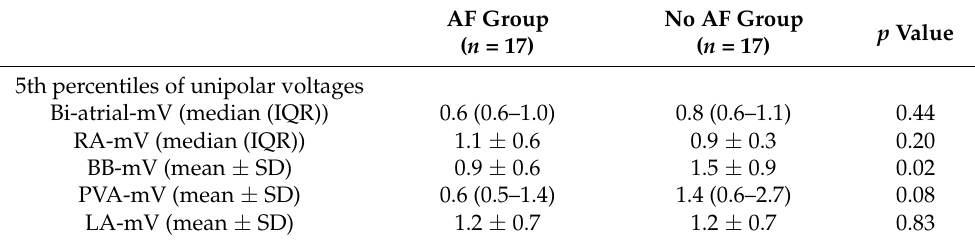
Table 3. The lowest unipolar voltages presented for the AF and no AF group.